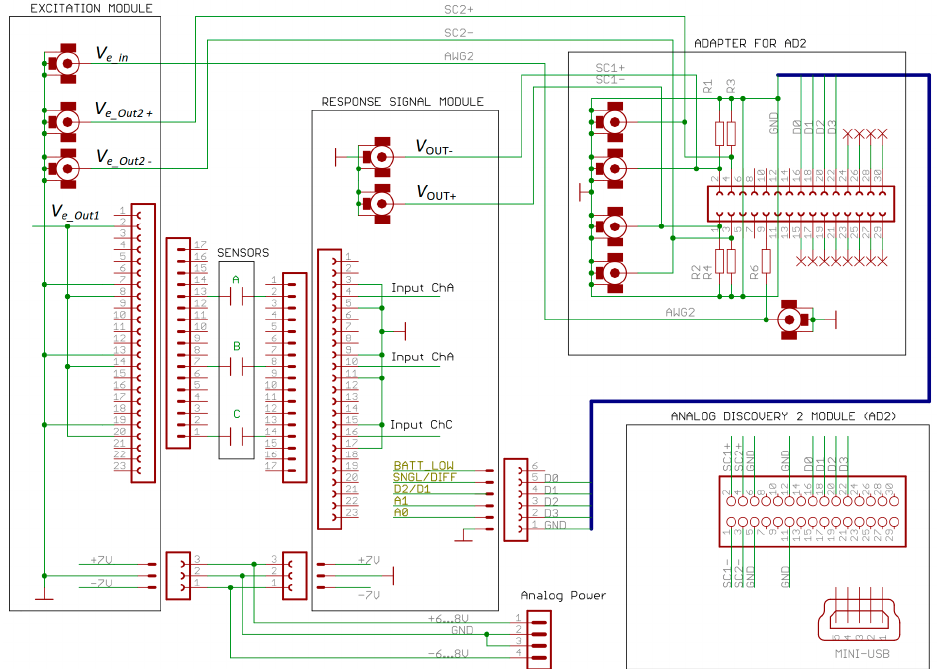
Figure A1. Connection diagram of analyzer modules.